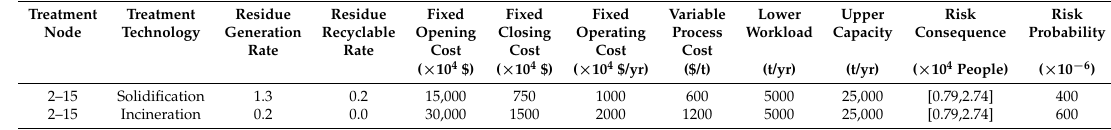
Table 2. Candidate treatment